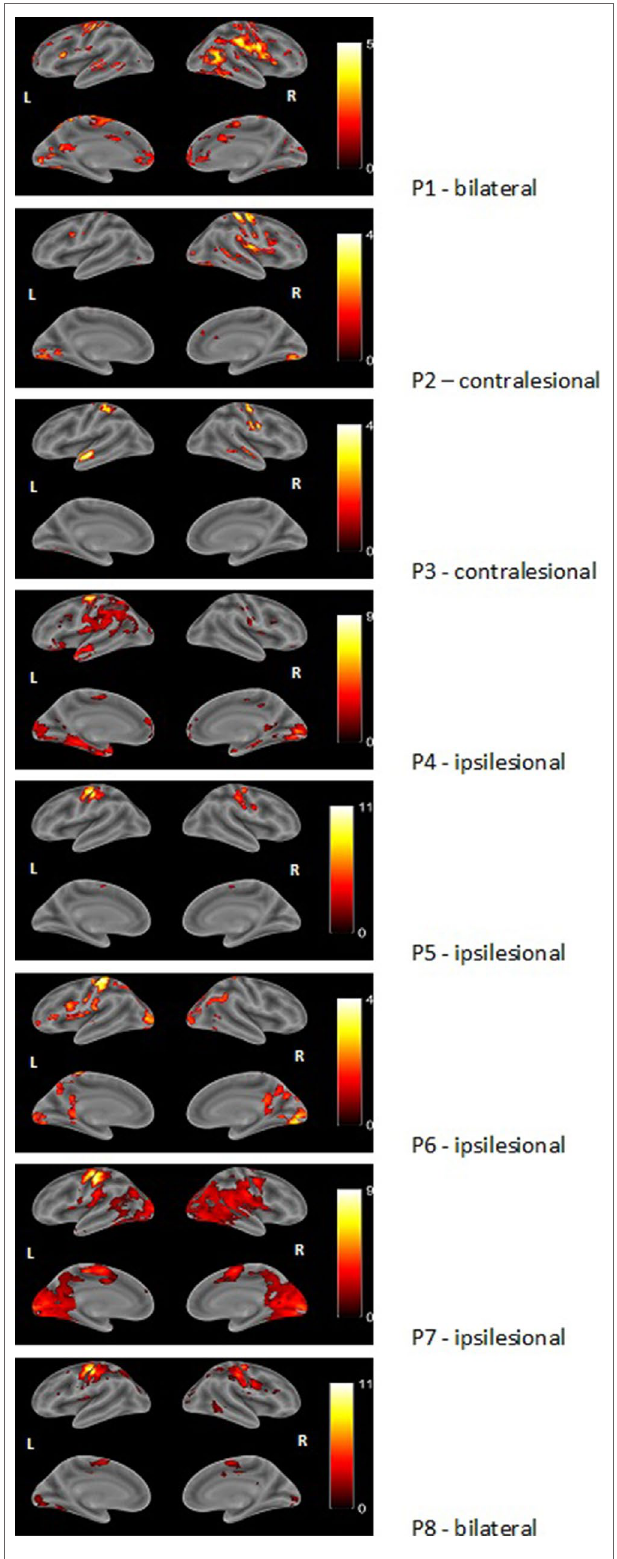
FIgURE 2 | Examples of render images of the three different patterns of activation during motor task with the impaired right hand (MR task). Color bar represents